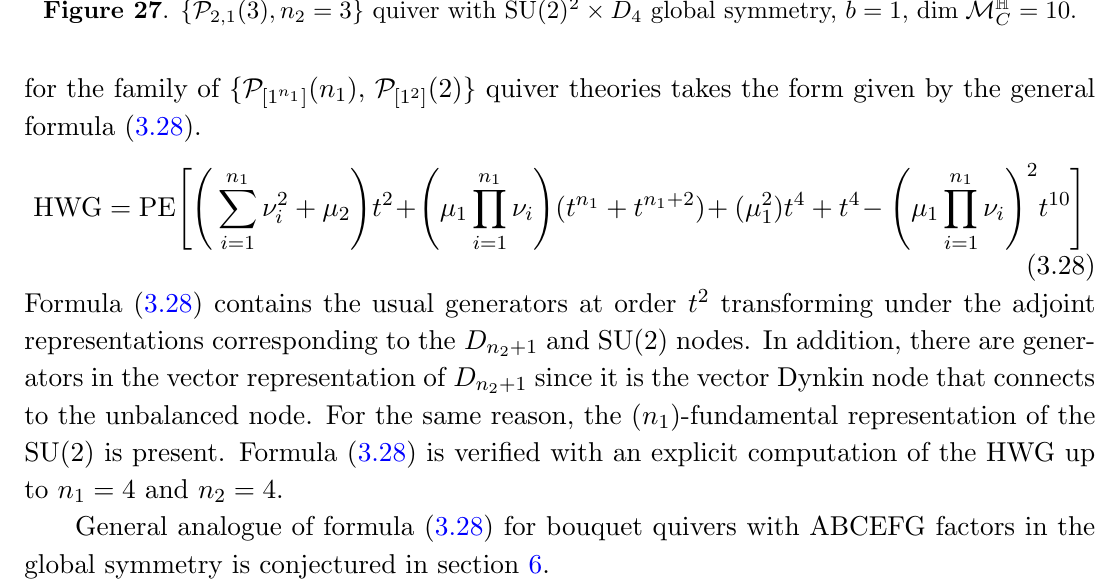
Figure 27 . fP 2 ; 1 (3) ; n 2 = 3 g quiver with SU(2) 2 (cid:2) D 4 global symmetry, b = 1, dim M H